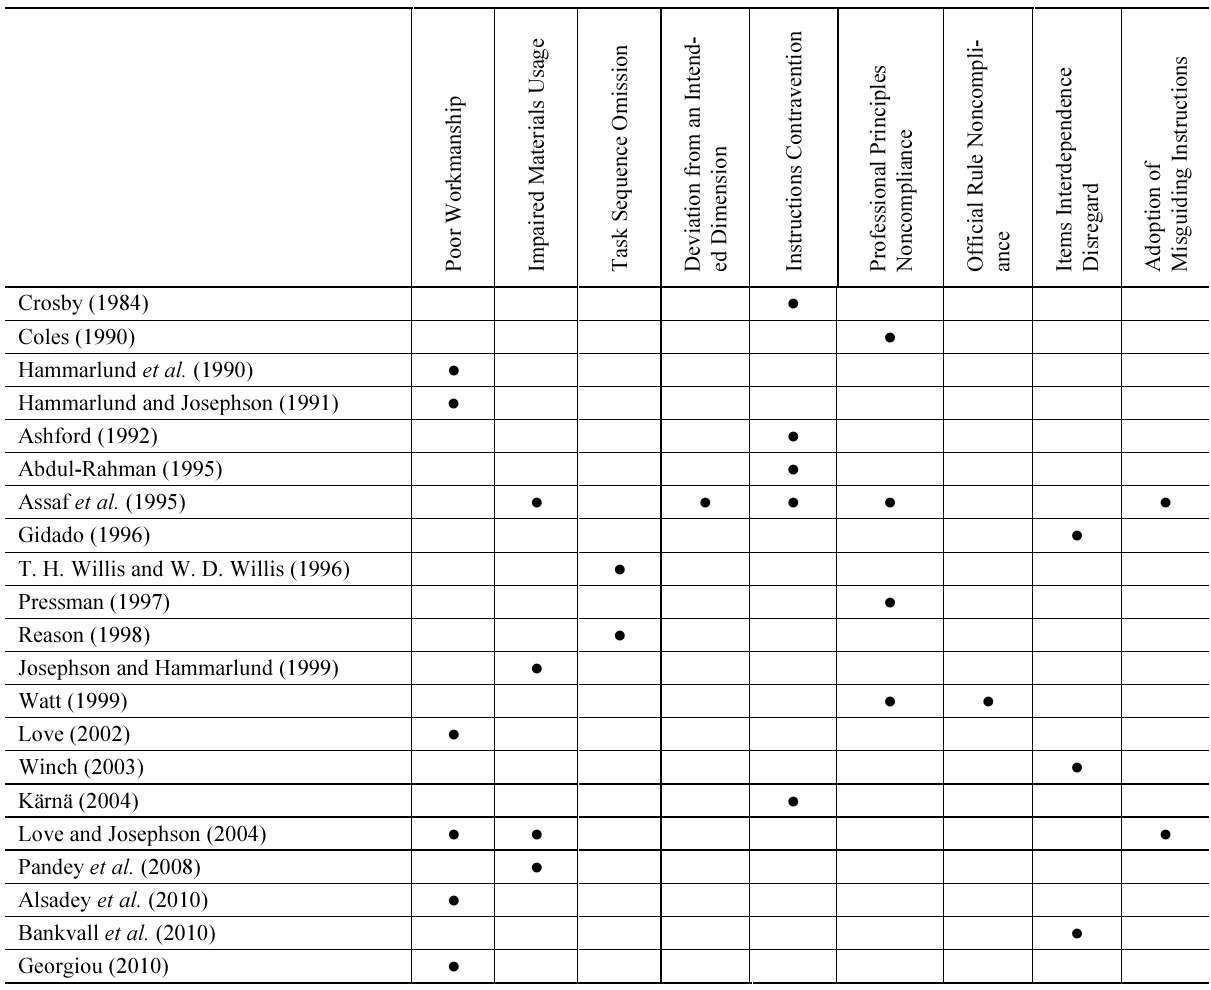
Table 1. Literature syntheses in which defective act classifications are